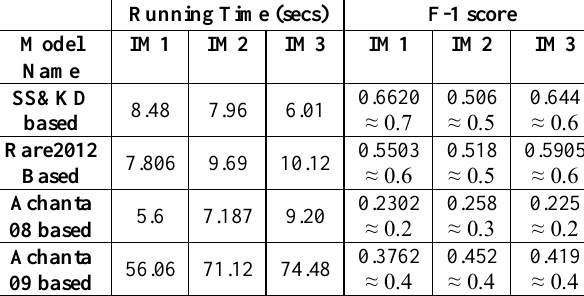
Table 1. Comparative analysis of Saliency based Segmentation Models for terrestrial